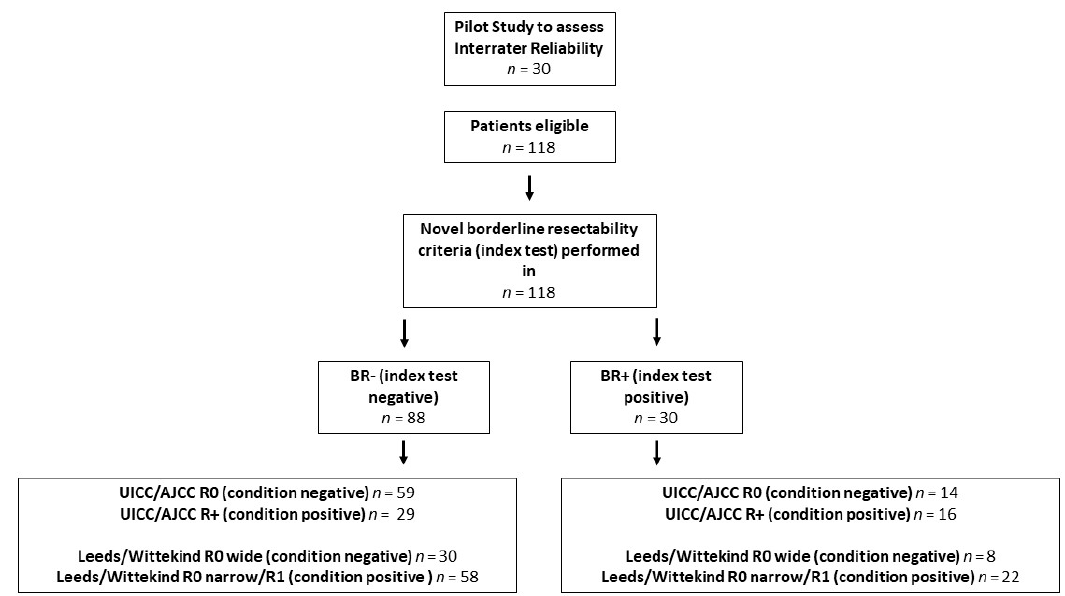
Figure 3. A Study Flow Chart according to the STARD 2015 List of essential items for reporting diagnostic accuracy studies. BR-: not borderline resectable; BR + : borderline resectable; UICC / AJCC: Union International Contre le Cancer / American Joint Committee on Cancer.